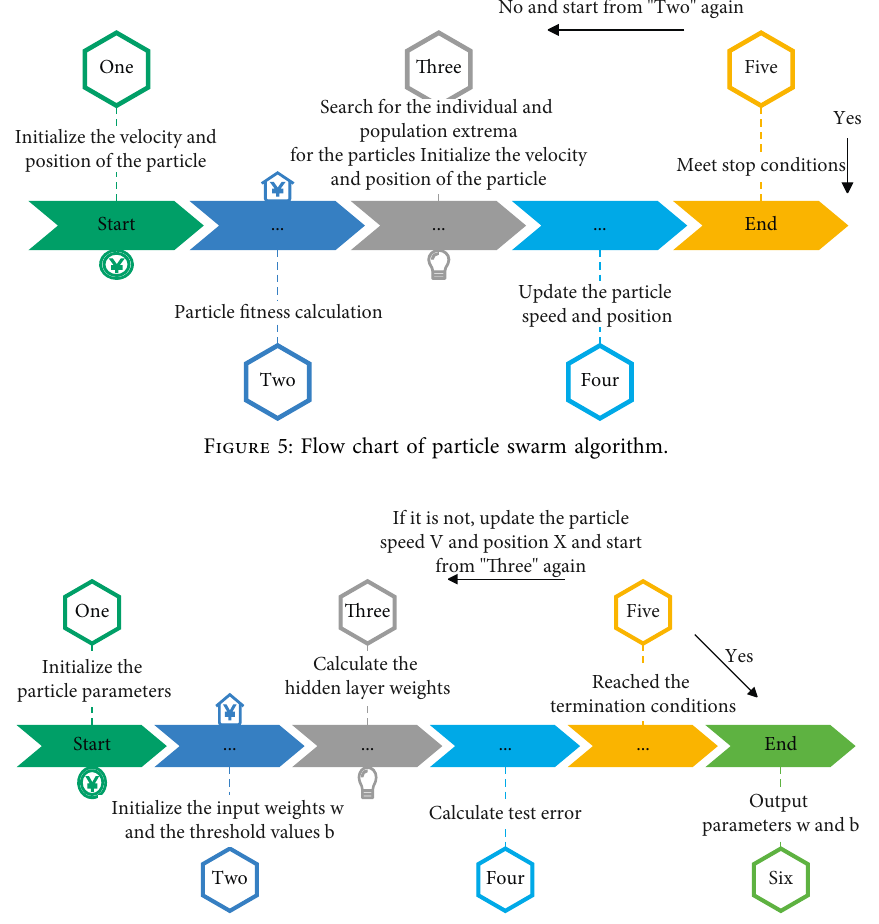
Figure 6: PSO-ELM algorithm flow chart. Table 2: Parameter settings of particle swarm algorithm.